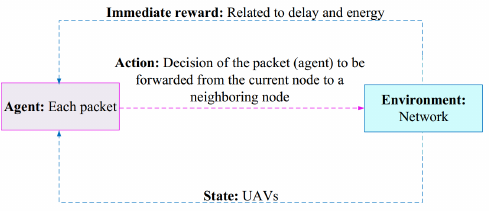
Figure 29. Learning process in QMR. Table 11. The most important advantages and disadvantages of